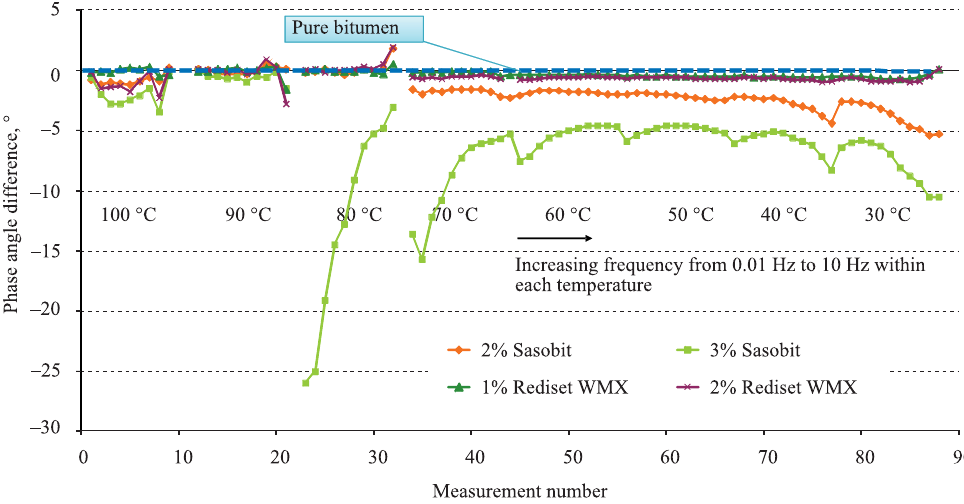
Fig. 4. Difference in phase angle of WMA binders relative to pure bitumen